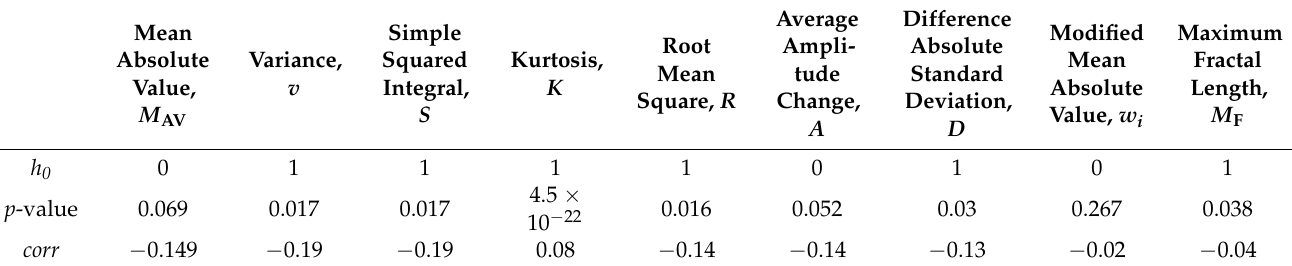
Table 1. T -test and Pearson correlation values between discharge and noise